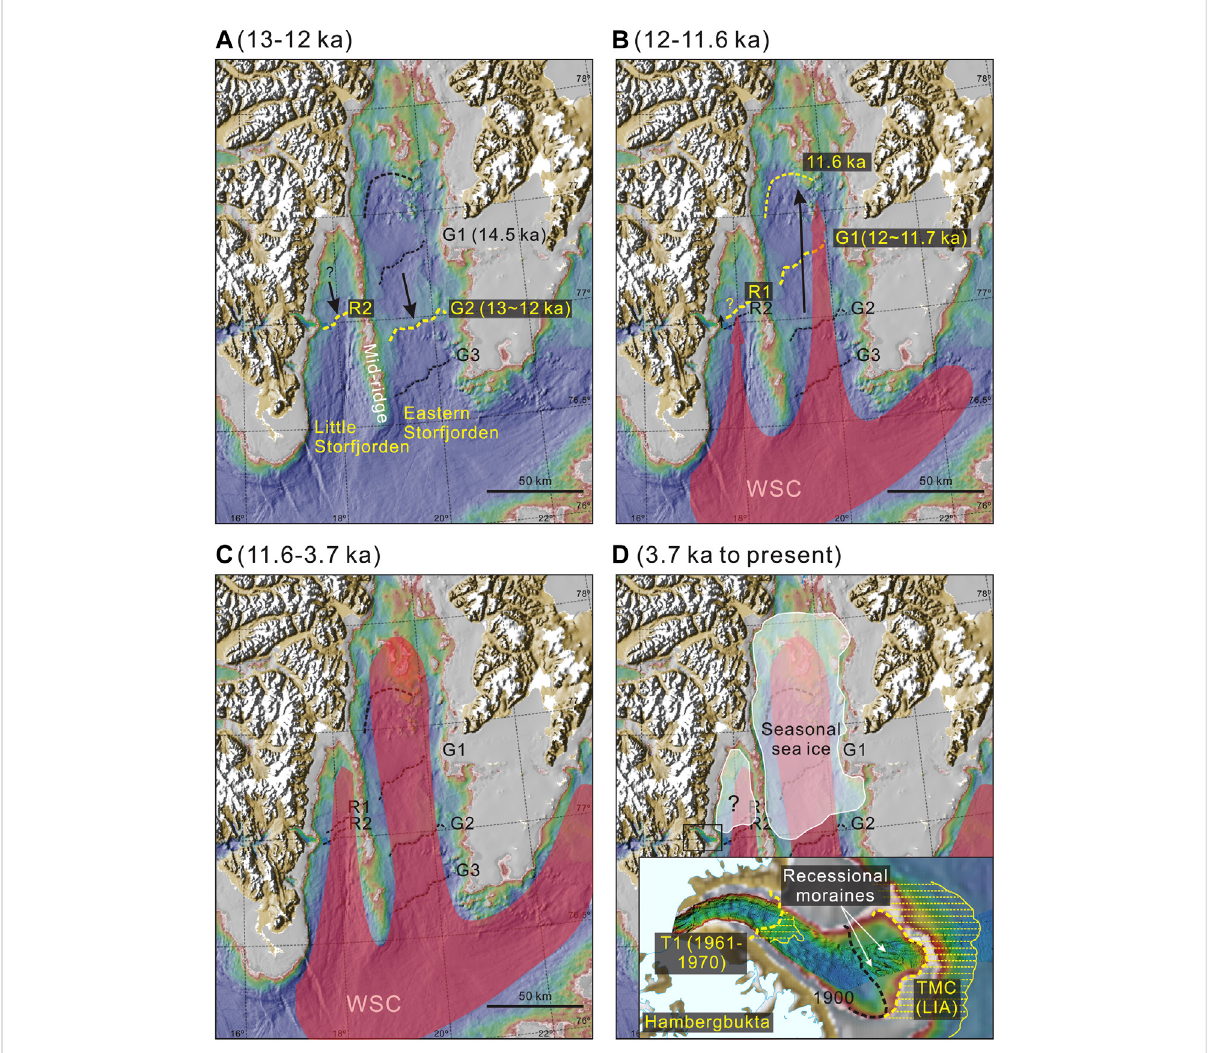
FIGURE 11 Reconstruction of glacial history in the Hambergbukta and Little Storfjoden since the Younger Dryas: (A) Younger Dryas stadial period (13 – 12 ka), (B) YoungerDryastoHolocenetransition(12 – 11.6 ka), (C) theearlytomiddleHolocene(11.6 – 3.7 ka),and (D) thelateHoloceneincluding the Little Ice Age glaciation in Hambergbukta. The extent of seasonal sea ice in panel (D) was inferred based on sediment core records from RasmussenandThomsen(2015).BlackdottedlinesindicategroundingzonewedgesincludingG1 – G3.Withtheblackarrowsindicatingice fl ow directions, yellow dotted lines indicate temporal variations in the front of the marine-based glaciers in Storfjorden combined with the previous reconstruction (Nielsen and Rasmussen,